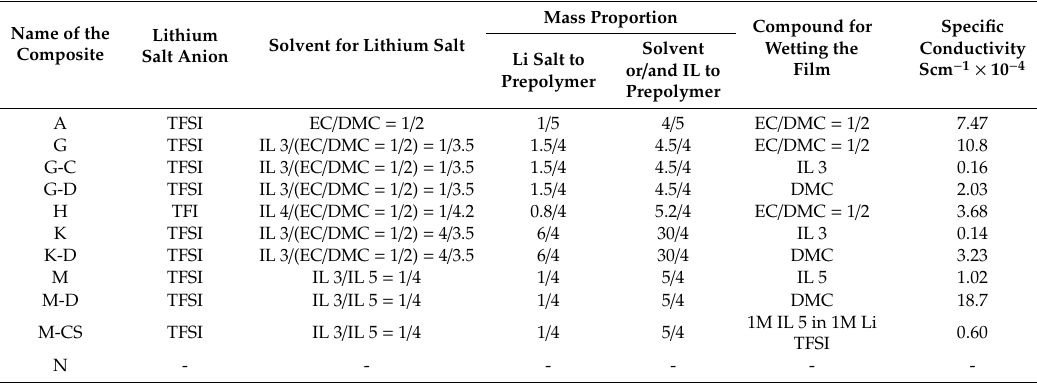
Table 5. Compositions of the PSUR-based UV-cured composites containing reactive ILs obtained in the study and the results of specific conductivity determinations. Composite prepared without IL (A) was included for comparison. Composite N without any solvent and lithium salt was also prepared for Tg determinations